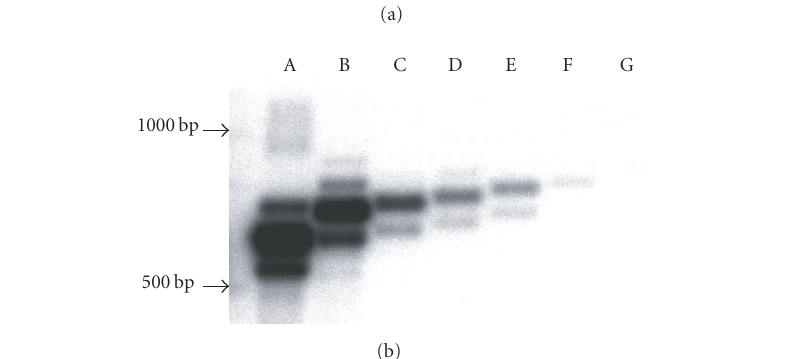
map to the opposite strand of L1 5 (cid:2) UTR. It has been esti- mated that more than 80% of the TSS in the DBTSS